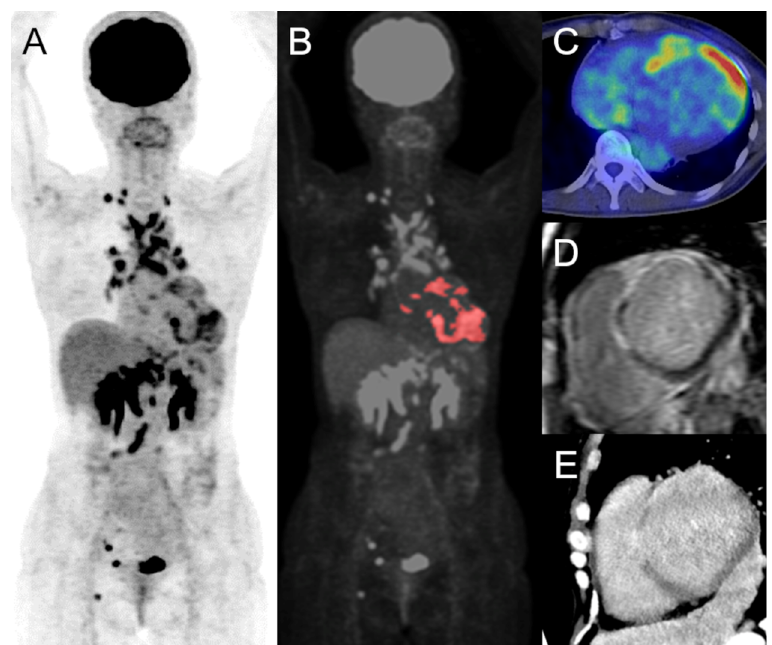
Figure 3. Volume-based analysis of FDG-PET. The maximum intensity projection ( A ), colored on the cardiac lesion ( B ), FDG-PET/CT of axial image ( C ), short-axis images of delayed-enhancement MRI ( D ), and CT ( E ) of cardiac sarcoidosis are displayed, respectively. There are focal uptakes in the left and right ventricles, which is concordant with the delayed enhancement on MRI and CT, indicating active cardiac sarcoidosis. The estimated SUVmax, cardiac metabolic volume, and cardiac metabolic activity were 10.8, 51.8, and 231.7 mL, respectively. There are also multiple FDG uptakes in the supraclavicular, mediastinum, hilum, abdomen, pelvis, and right inguinal lymph nodes. FDG, 18F-fluorodeoxyglucose; PET, positron emission tomography; CT, computed tomography; MRI, magnetic resonance imaging; SUV, standardized uptake value.